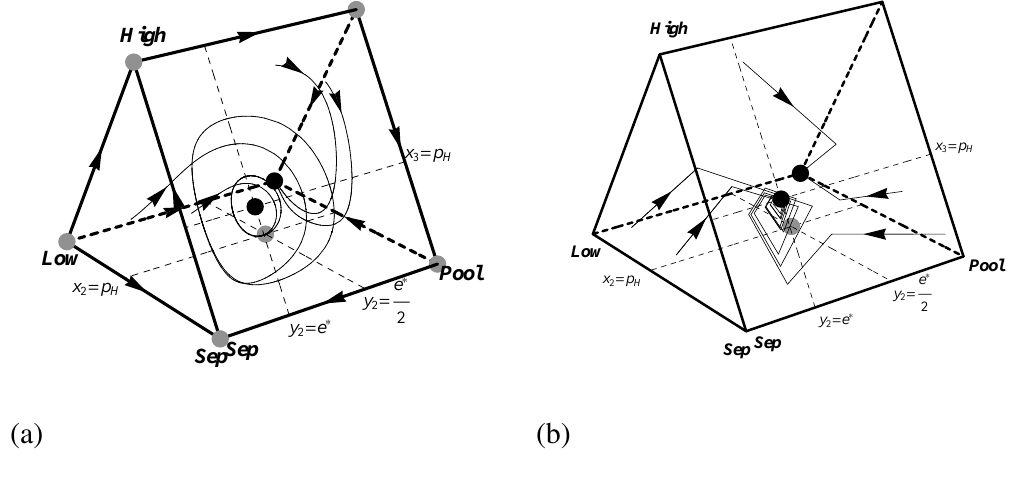
Figure 5. Phase portraits showing the dynamics of the pruned Spence signaling game with 0 < e ∗ < 1 for (a) the replicator dynamic and (b) the best response dynamic. Black and grey dots indicate stable and unstable rest points